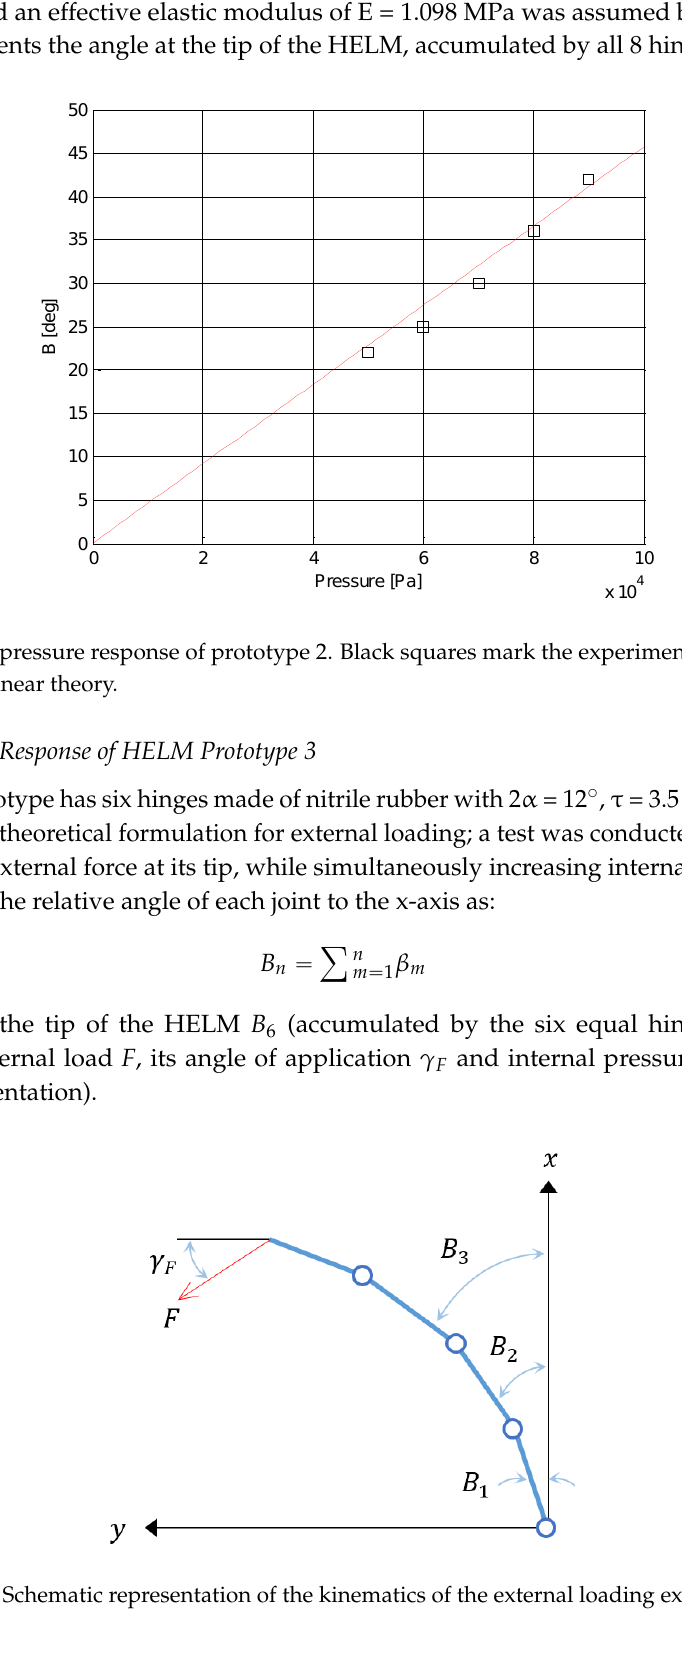
Figure 7. Schematic representation of the kinematics of the external loading experiment.